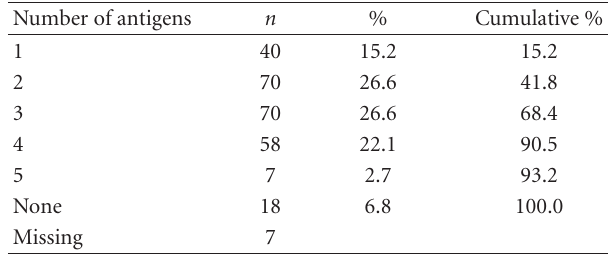
Table 4: Expression of single or multiple antigens in EOC. Number of antigens